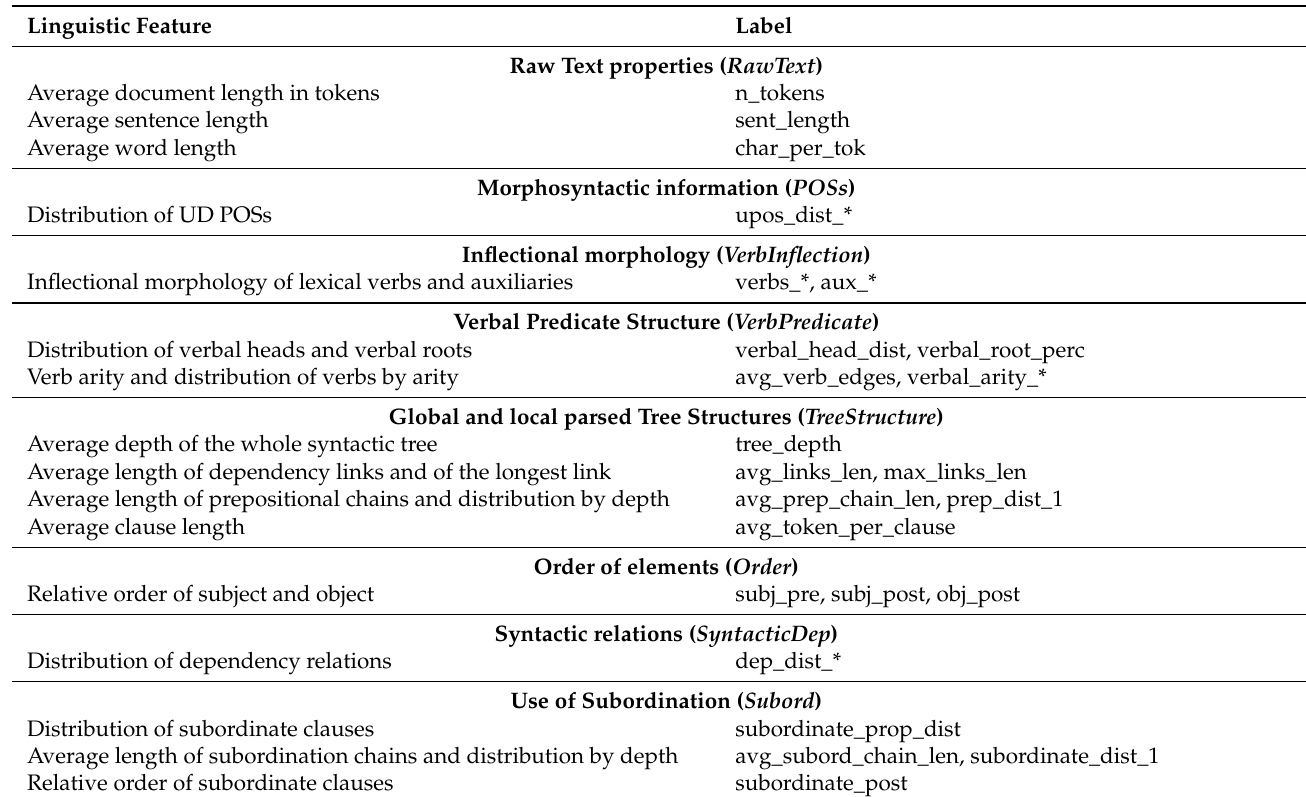
Table 1. Linguistic indicators aggregated by